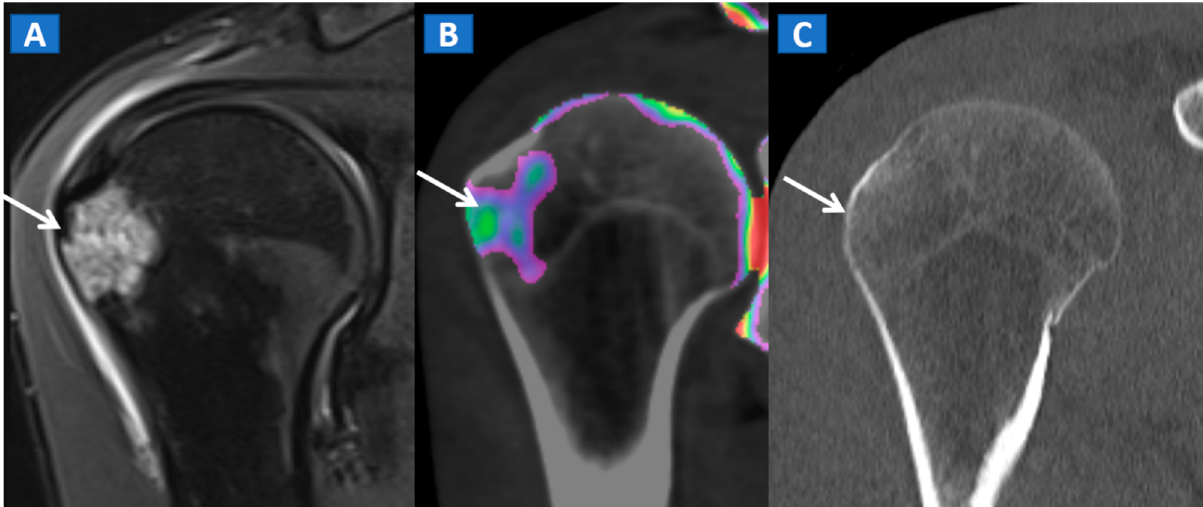
Figure 8. A 35-year-old male with traumatic BME of the humeral head. On the coronal STIR MRI image ( A ), post-traumatic BME of the humeral head is depicted as a hyperintense signal in the subcortical area (arrow). The presence of BME is confirmed on the 2D DECT coronal 1 mm reconstructed image ( B ) (arrow). The high resolution 1 mm coronal CT image with bone window ( C ), rules out the presence of cortical fractures.